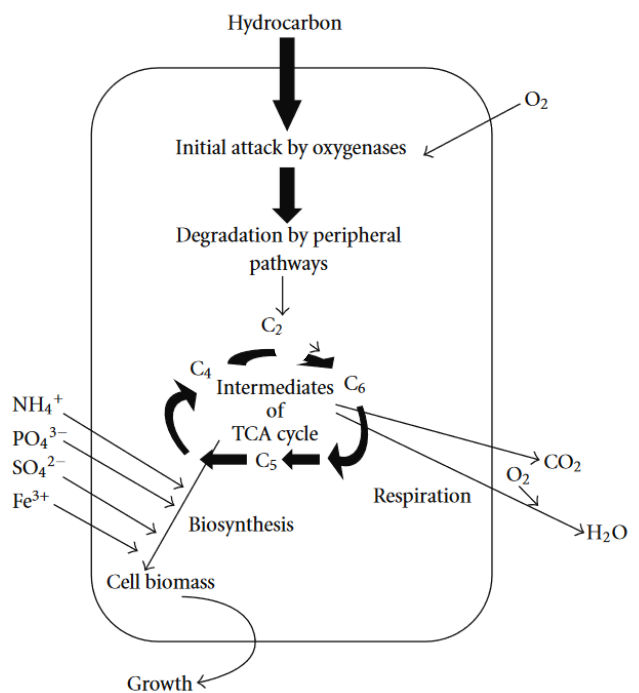
Figure 3. Biodegradation pathway of hydrocarbon by bacteria [51].